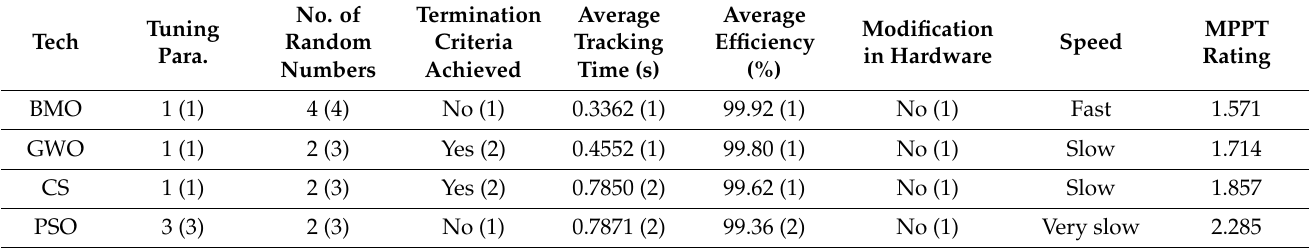
Table 4. Comparison of MPPT rating.